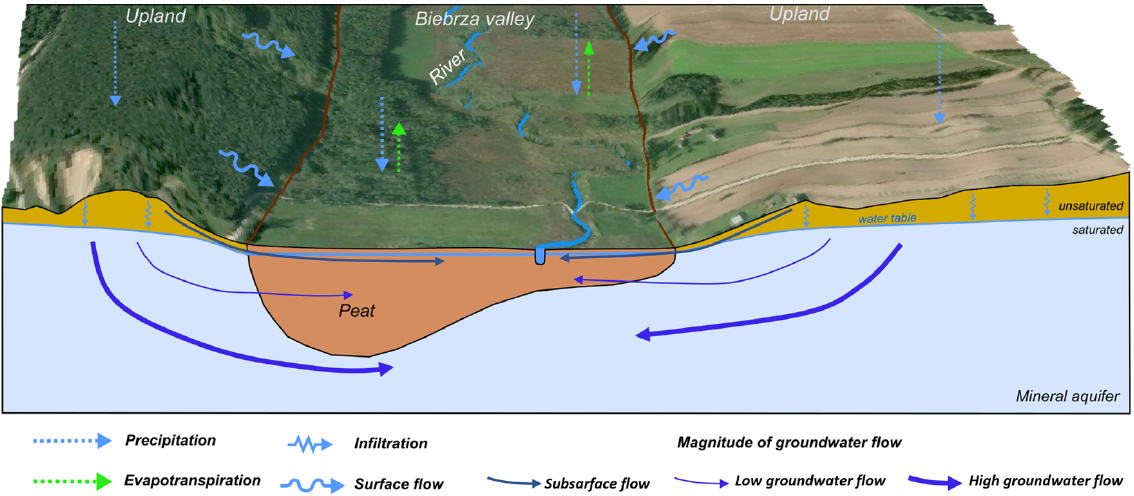
Figure 11. A schematic conception of groundwater flow into the Biebrza river (modified from [5]).